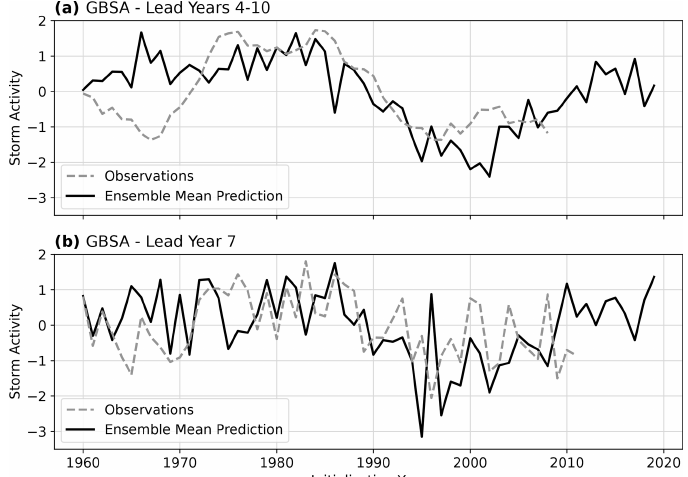
Figure A1. Exemplary time series of ensemble mean predictions (black, solid) and corresponding observations (grey, dashed) of German Bight storm activity (GBSA) for lead years 4–10 (a) and lead year 7 (b)